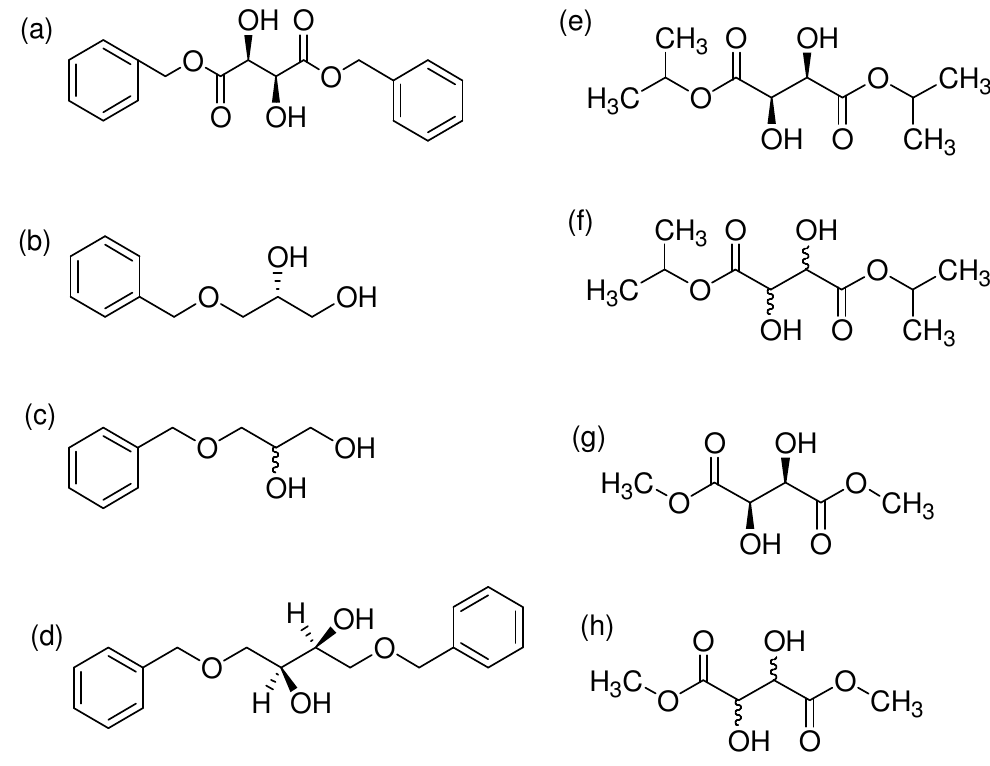
Figure 1. (a) (+)-Dibenzyl- L -tartrate; (b) ( R )-(+)-3-Benzyloxy-1,2-propanediol; (c)